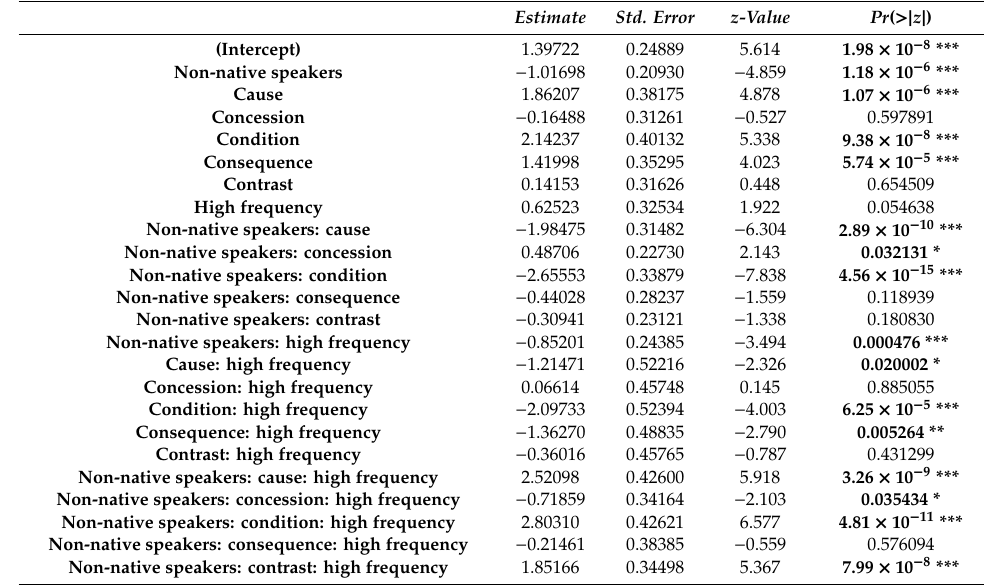
Table 4. Output of Our Main